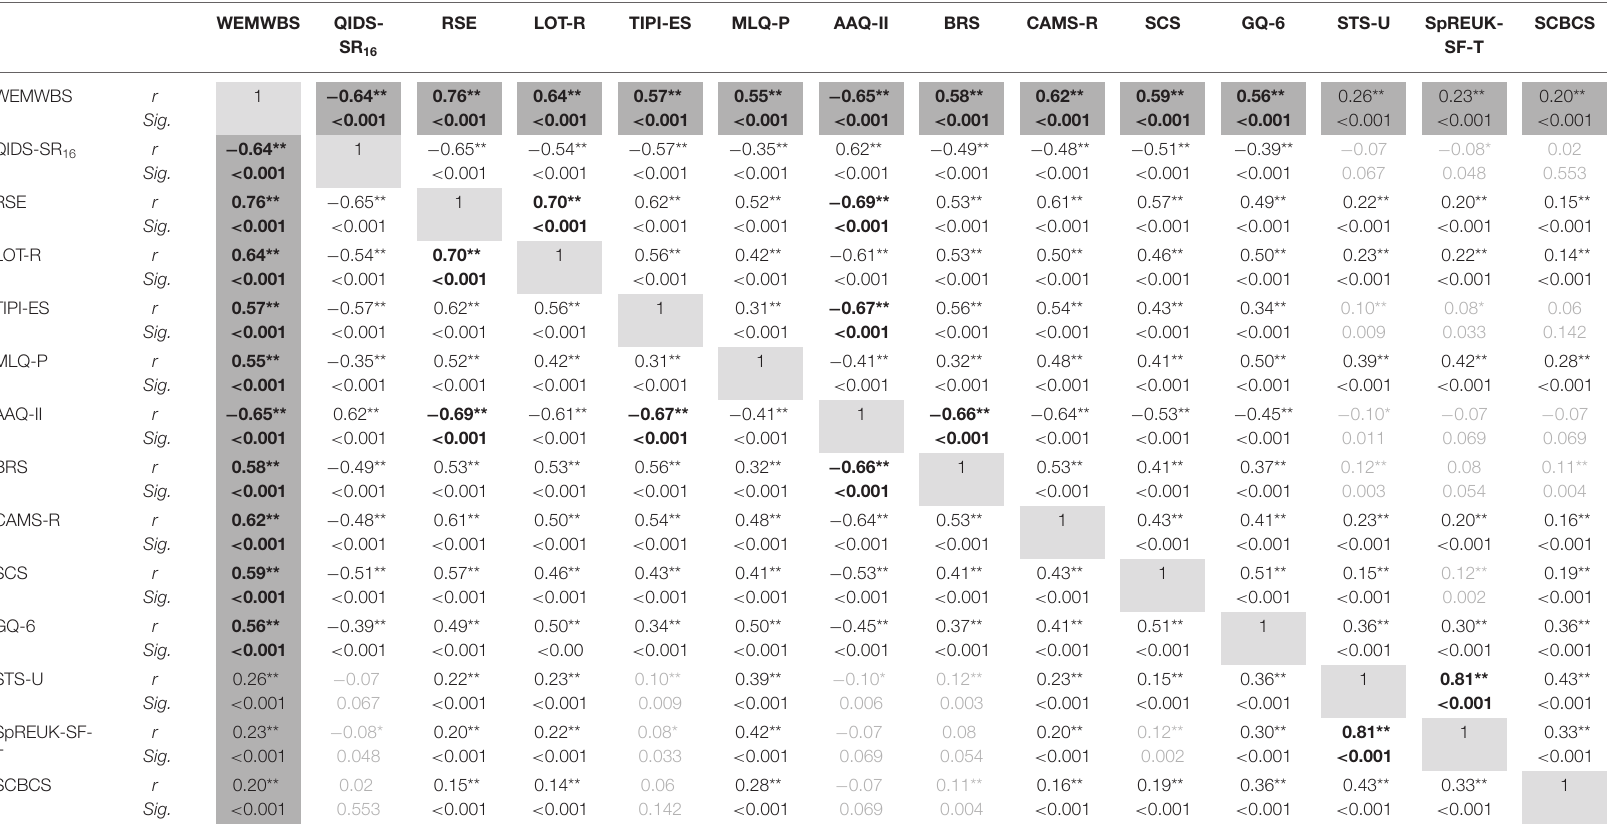
TABLE 3 | Correlation matrix of main (primary and secondary) measures at baseline (time point 1;